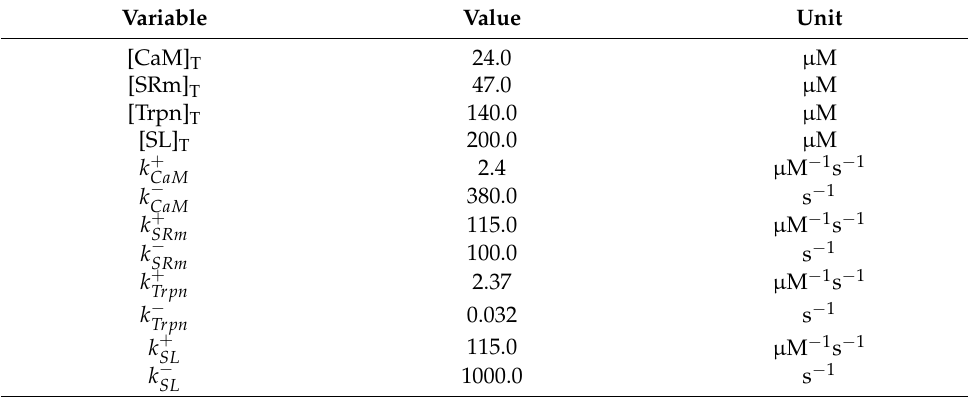
Table A3. Buffering